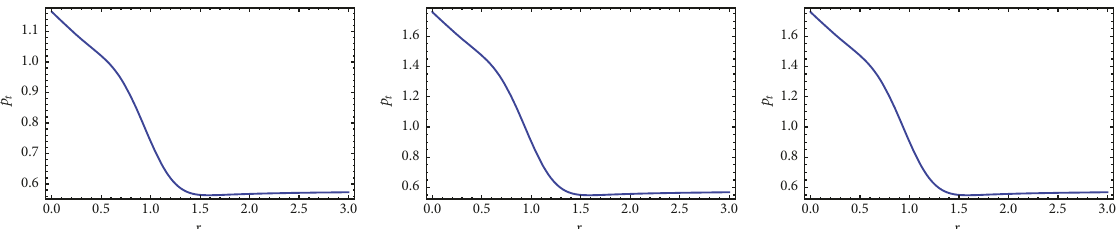
0.0 Figure 5: This figure represents the variation of 𝑝 𝑡 versus 𝑟 (km) for the strange star taking 𝛽 = 1 , 𝛽 = 2 , and 𝛽 = 3